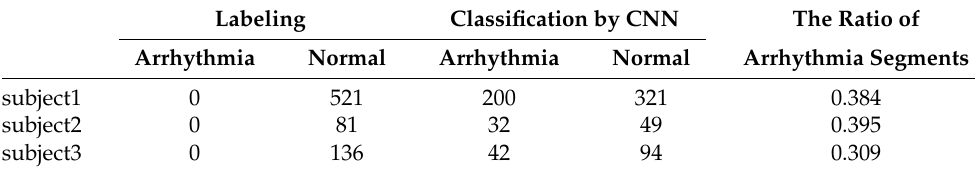
Table 3. The results of labeling and classification of segments of healthy subjects.